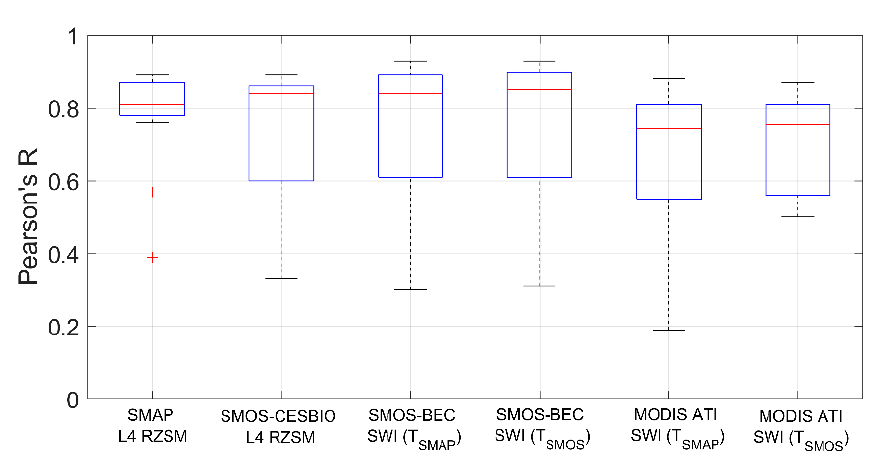
Figure 3. Pearson’s correlation coefficients (R) between the in situ RZSM and the six RZSM estimates across REMEDHUS (by stations).